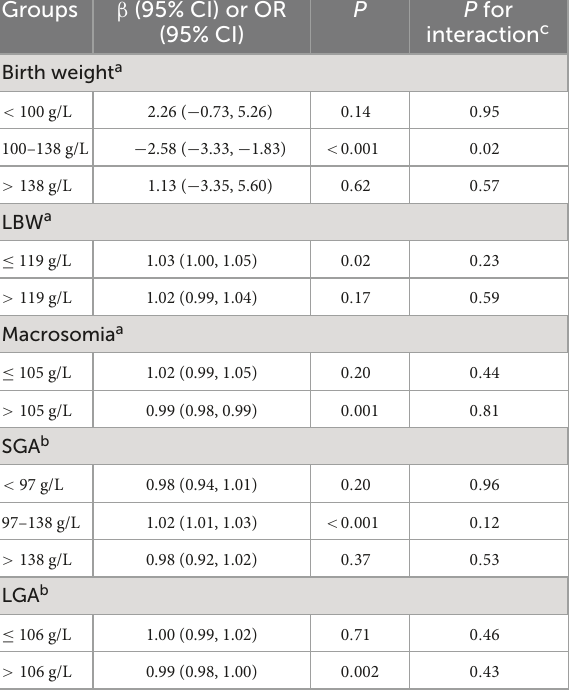
TABLE 2 Influences of per 1 g/L increase in maternal hemoglobin concentration at different segments on birth weight outcomes.